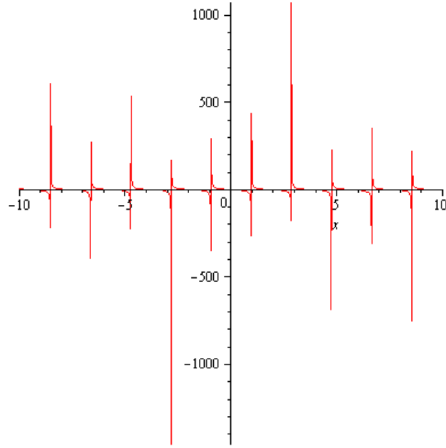
Figure 3. The solitary wave 3D graphics of Equiation (25) provides a periodic solution profile for, A 0 “ 1, m “ 1, ω “ ´ 1, k 1 “ 1, k “ 2, l “ 2, A “ 2, B “ 3, µ “ 3, λ “ 1, E “ 5 within the interval ´ 1 ď x , t ď 1.